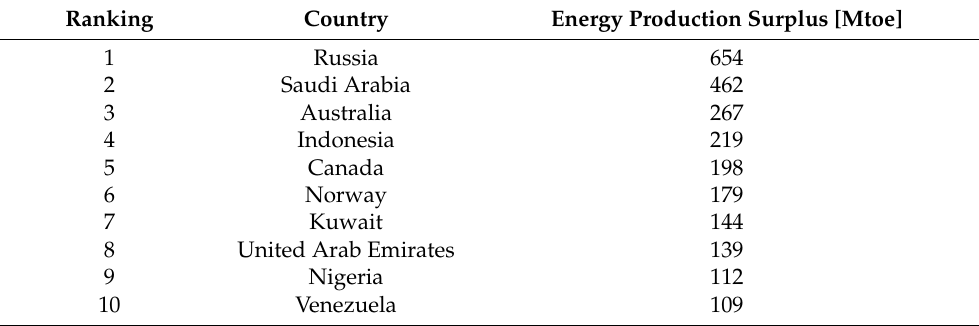
Table 5. Top-10 Countries (highest to lowest Mtoe values) for energy production surplus, obtained by the difference between energy production and consumption. Latest available data, expressed in Mtoe, refer to year